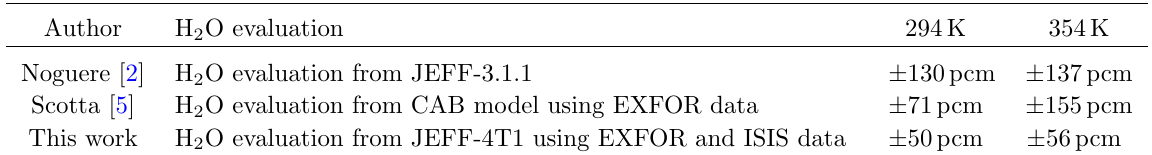
Table 5. Evolution of the k eff uncertainties for the MISTRAL-1 core at 294 and 354 K due to the thermal scattering laws of H 2